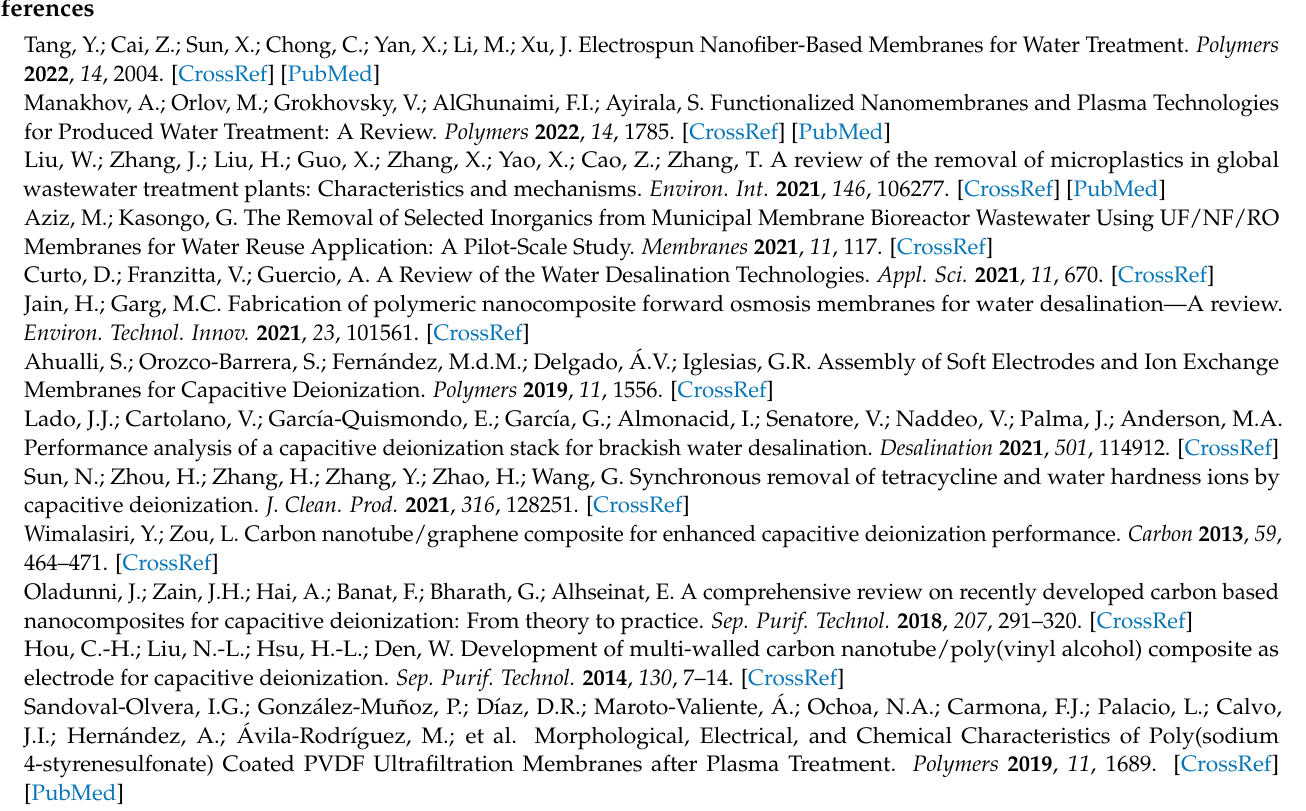
Figure S2: EDS analysis of carbon precursor used to prepare the freestanding electrode, Figure S3: BET analysis of commercial activated carbon used to prepare the free standing electrode, Table S1: Surface area analysis of commercial activated carbon used to prepare the free standing